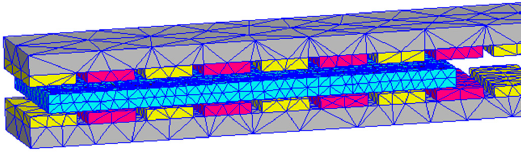
Figure 4. 3D-FEM model of a PMSLM.